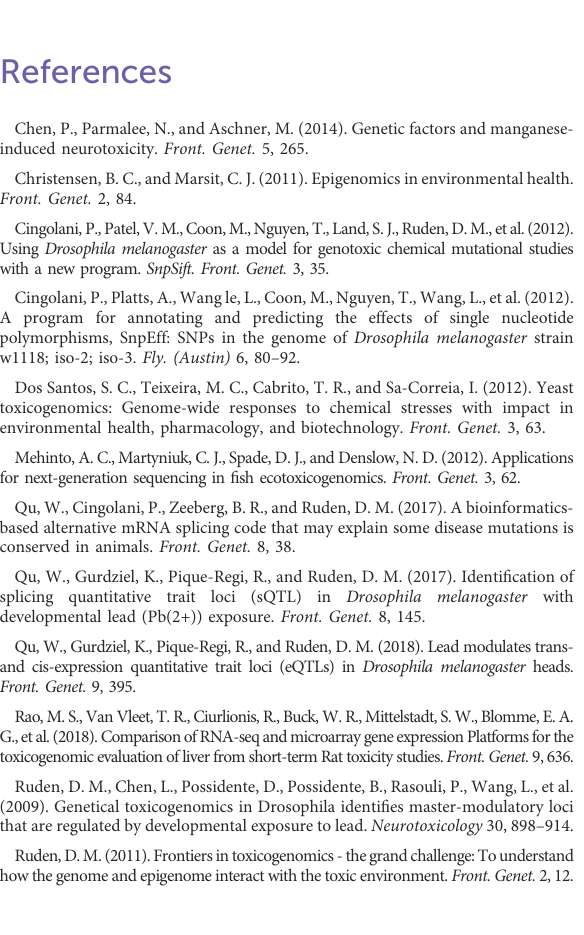
(B) Graph of cumulative downloads for all publications until November 2021 when Supplementary Table S1 was made. (C) Graph of cumulative views for all publications until November 2021 when Supplementary Table S1 was made. (B,C) *, indicates the abovementioned comparison paper from Dr.Liguori ’ s